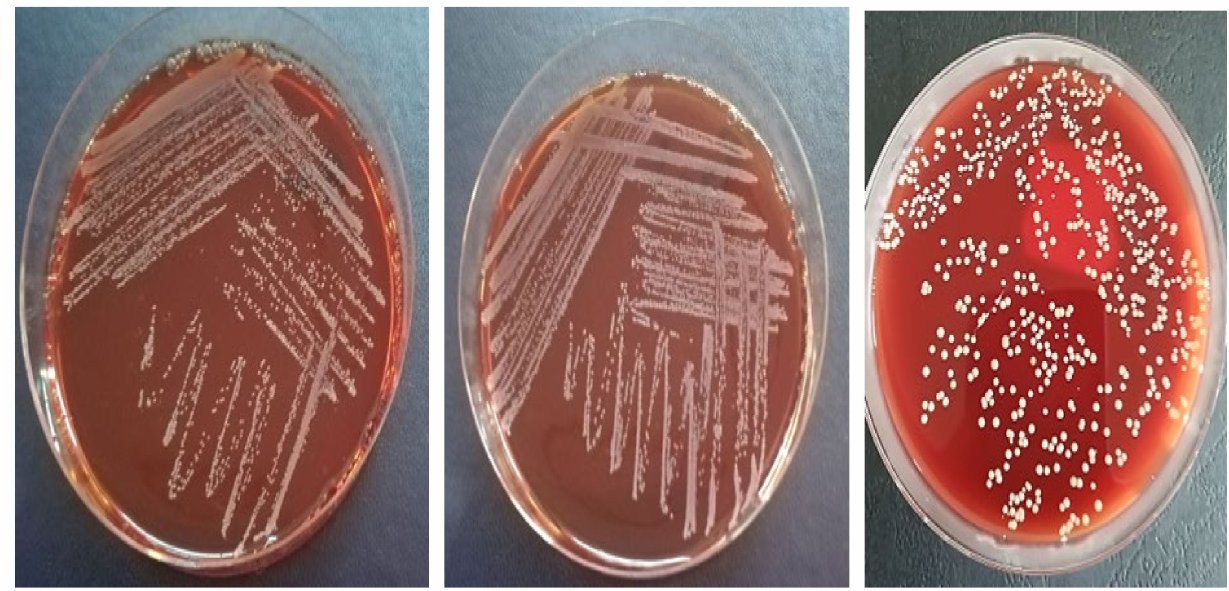
Figure 1. Aspects of the colonies obtained after inoculation on the blood agar medium.